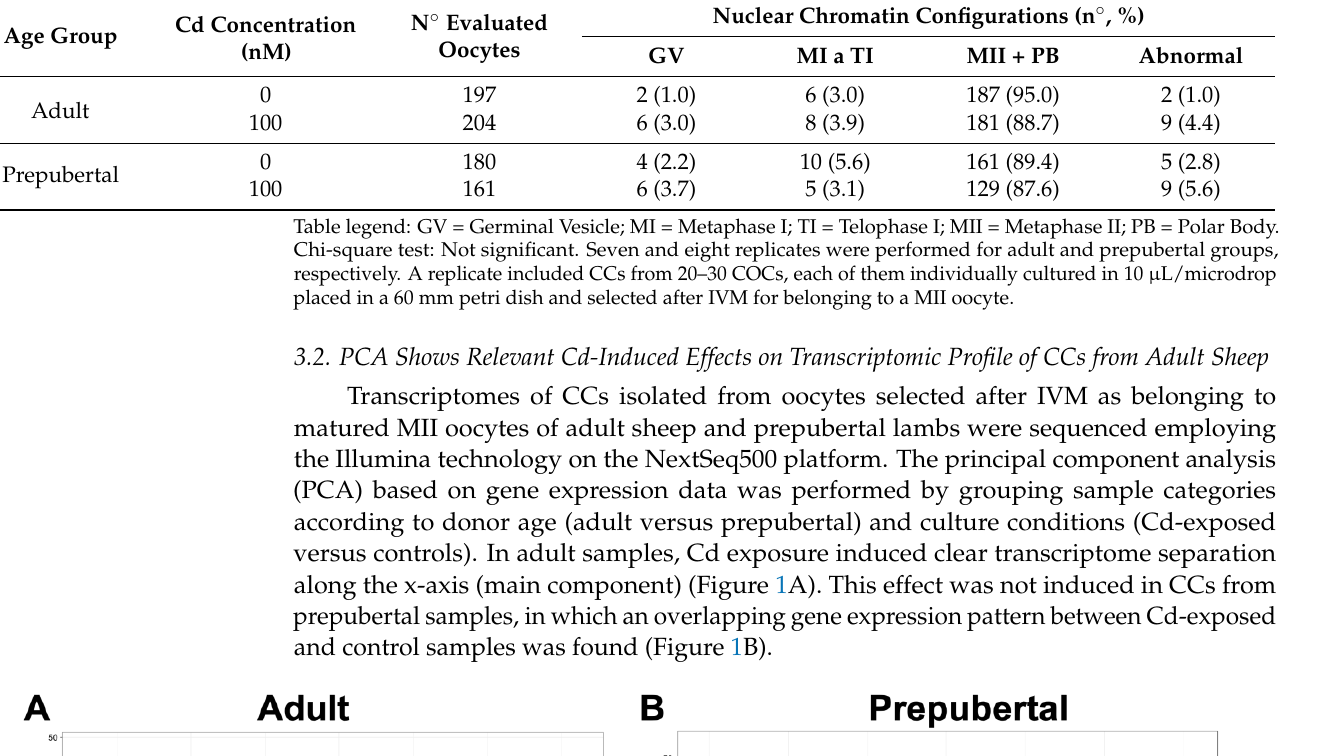
Table 2. Effects of in vitro exposure to nanomolar Cd during IVM on meiotic progression and maturation of oocytes from adult sheep and prepubertal lambs.